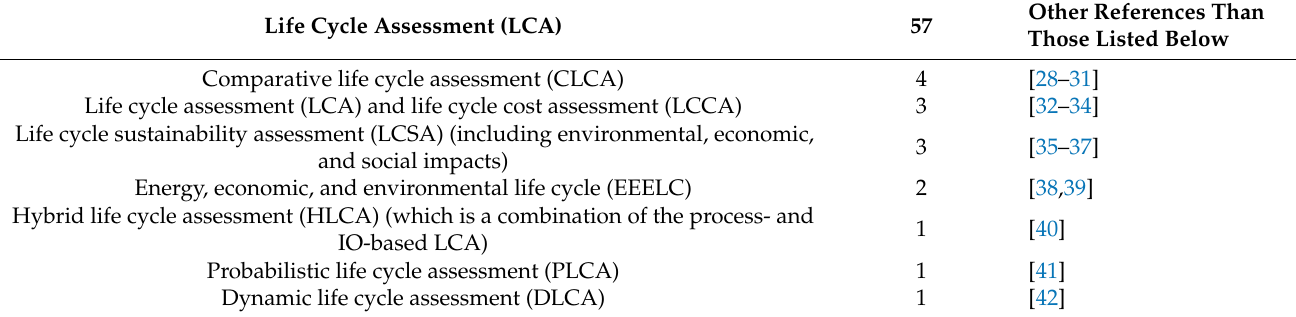
Table 4. Life cycle thinking approaches under uncertainty and their